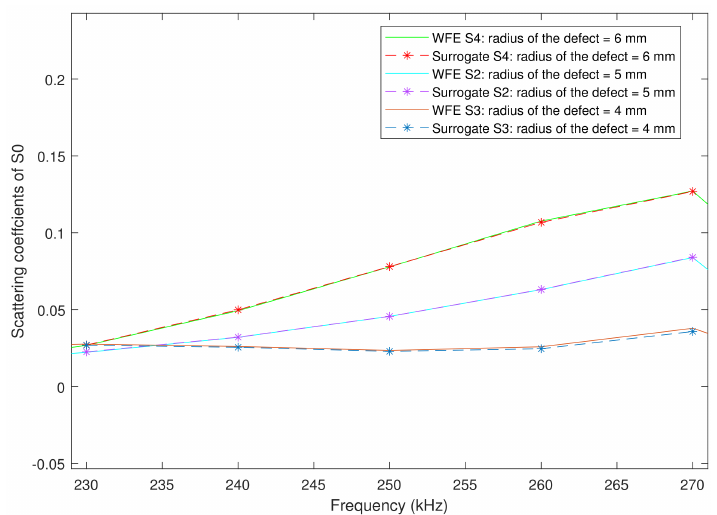
Figure 7. Comparison of scattering coefficients obtained by the surrogate model and WFE model; the dotted line represents the results of WFE model, the solid line represents the results of the surrogate model, and S2 and S4 represent the different locations of